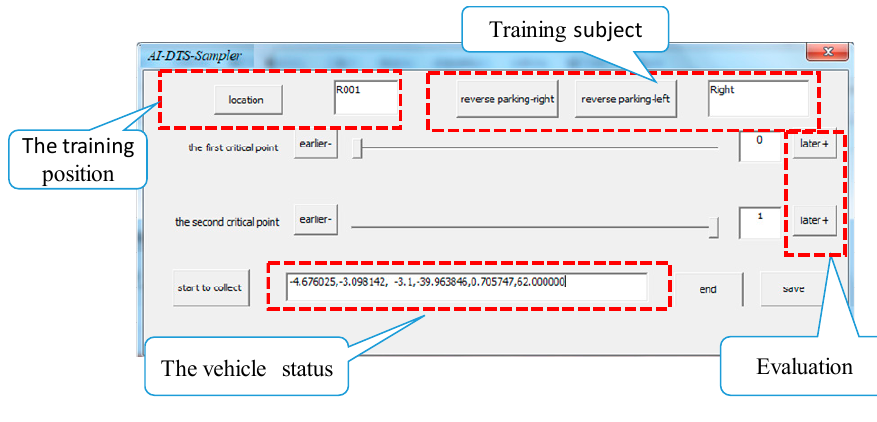
Figure 12. The Figure 12. The AI-DTS-Sampler.